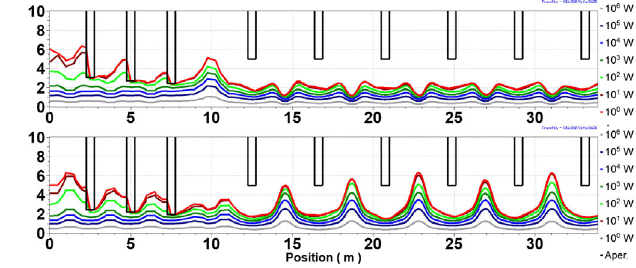
FIG. 13. Power density distribution in optimized collimation and VDS section for 1.5 GeV beam with 0.1% halo. (Top for X plane and bottom for Y